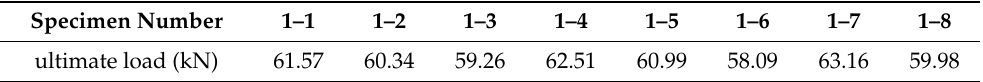
Table 7. Ultimate loads of the composite laminate specimens.